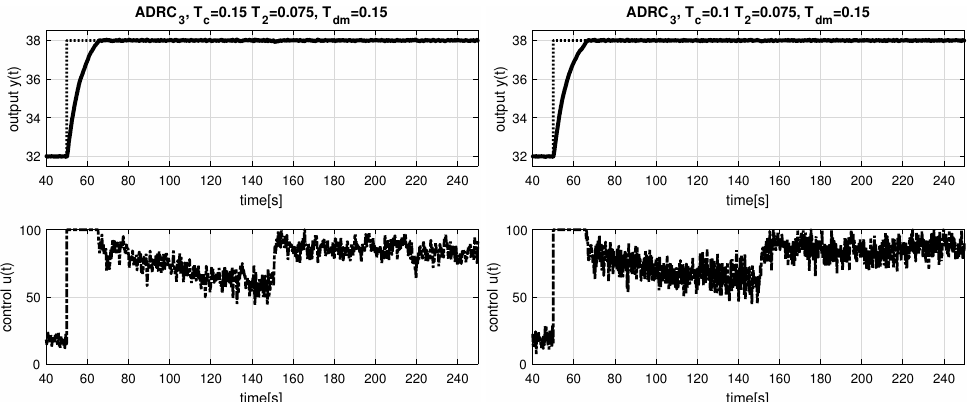
Figure 10. ADRC 3 : Transients corresponding to T 2 = T d /4 = 0.075 in (44) for “faster” ESO tuning with T c = T d /2 ( left ) and T c = T d /3 ( right ), T dm = T d = T d − 2 T 2 .